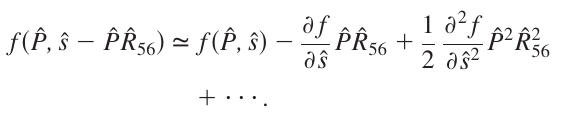
Fig. 2 some results of numerical simulations (for a finite bunch length). FEL radiation power W is scaled as follows: ^ W ¼ W= ð (cid:3)W Þ , where W b b is the electron beam power.